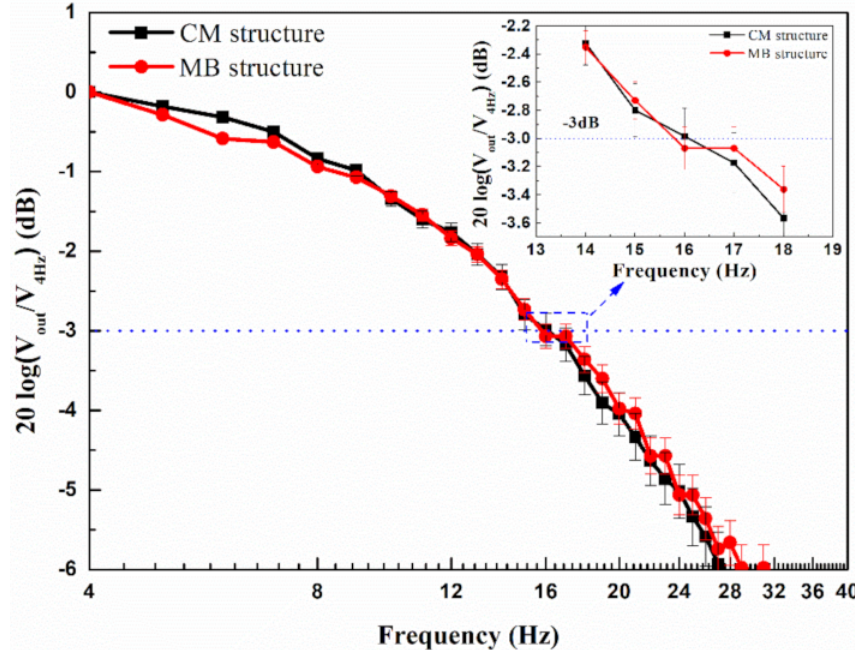
Figure 8. Measured frequency responses of the two